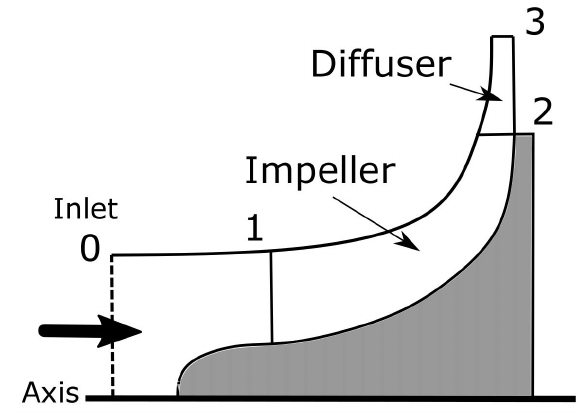
Figure 6. Cross section numbering in meridional view.